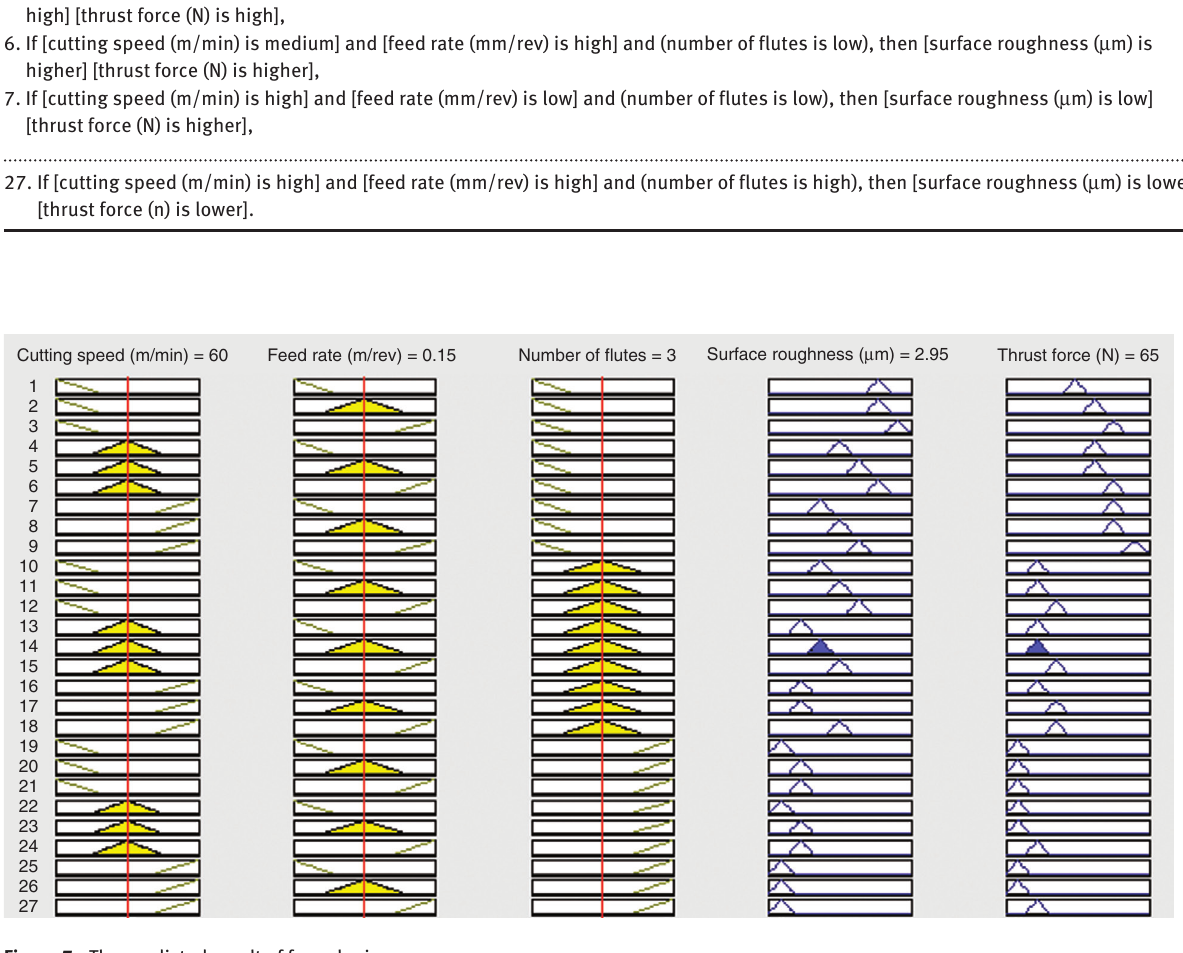
Figure 7 The predicted result of fuzzy logic.